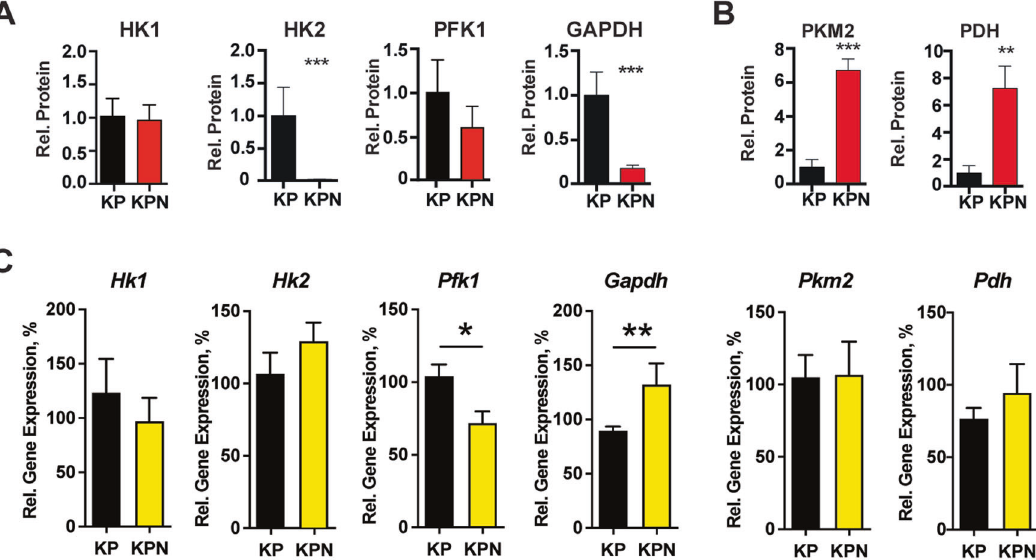
Fig. 3 Altered expression of glycolytic pathway enzymes in KPN versus KP murine NSCLC tumors. A , B Quanti fi cation of Western blots indicating reduced ( A ) or increased ( B ) expression of expression of the indicated glycolytic pathway enzymes in KPN versus KP tumors. C qRT- PCR showing steady-state mRNA expression of indicated genes in KPN versus KP tumors analyzed in ( A , B ). * p < 0.05, ** p < 0.01, *** p < 0.001, **** p < 0.0001 for all